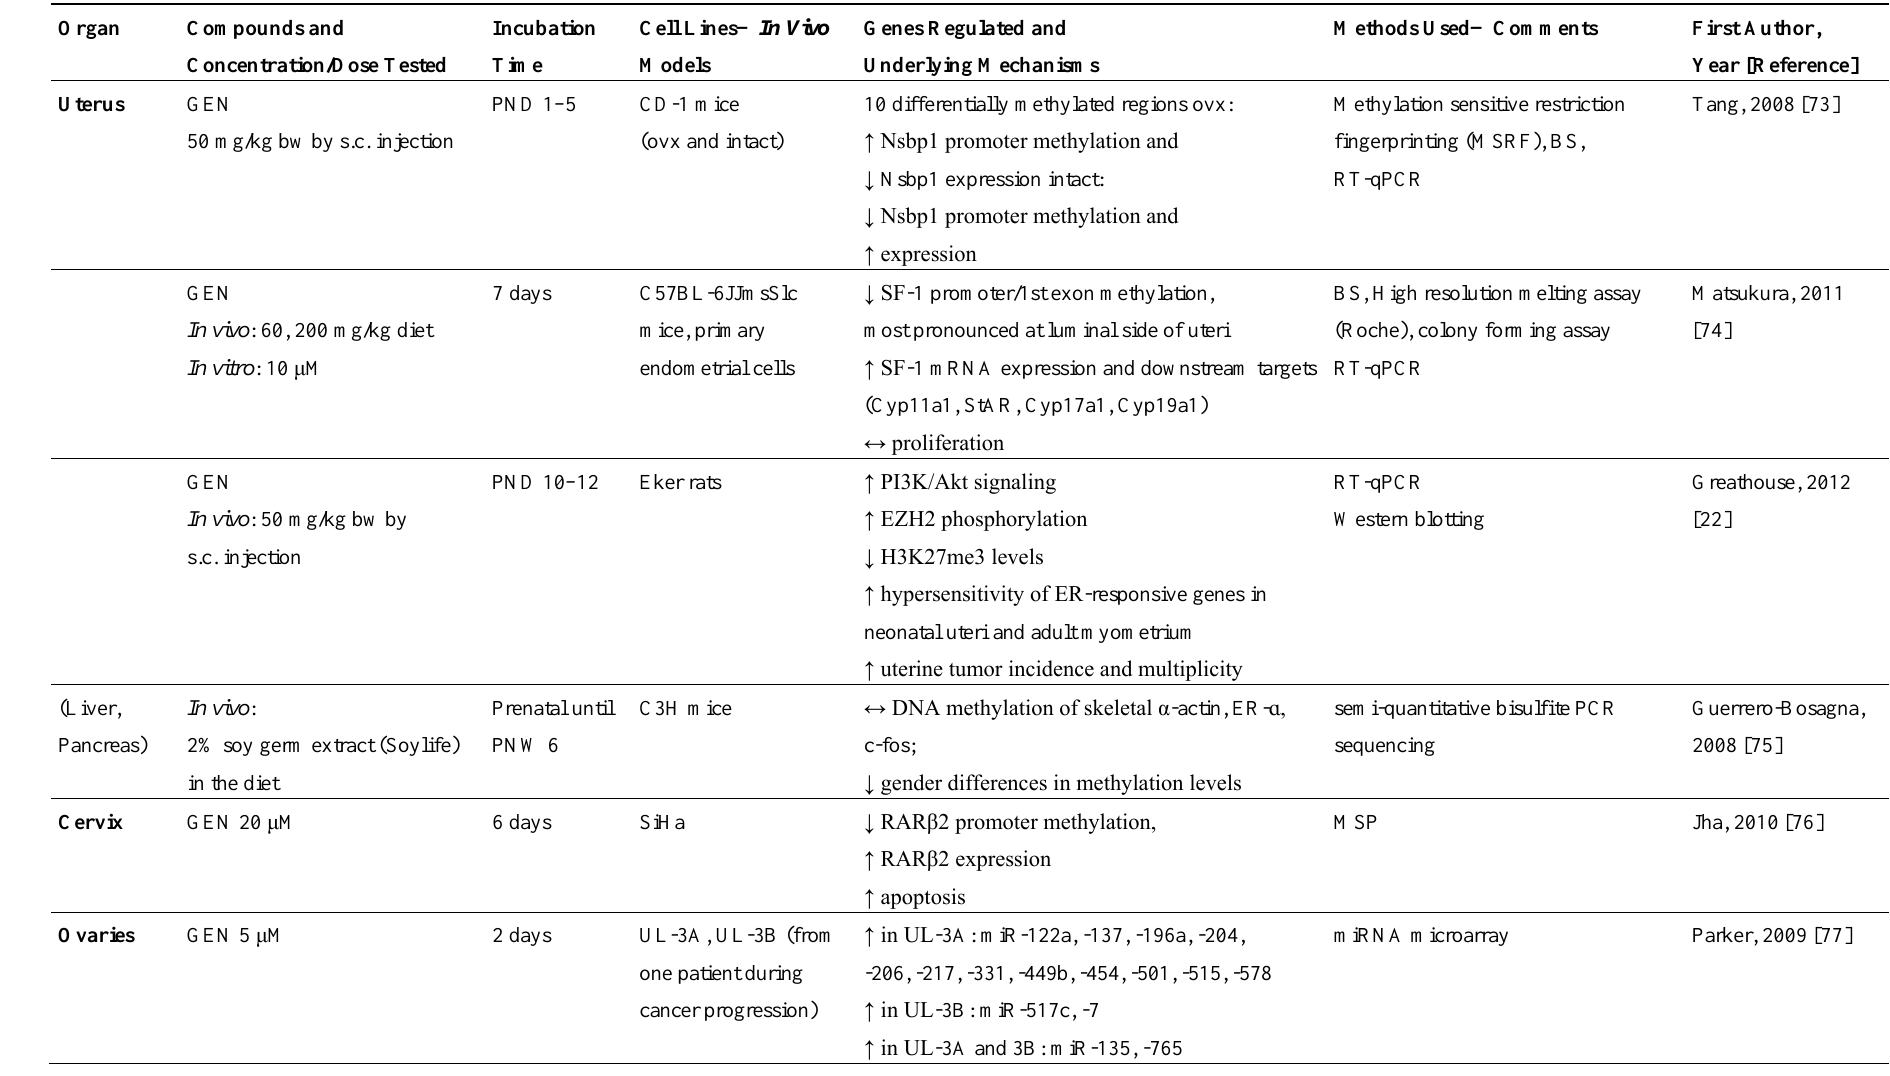
Table 2. Soy isoflavones targeting epigenetic mechanisms in uterus and ovaries in vitro and in vivo